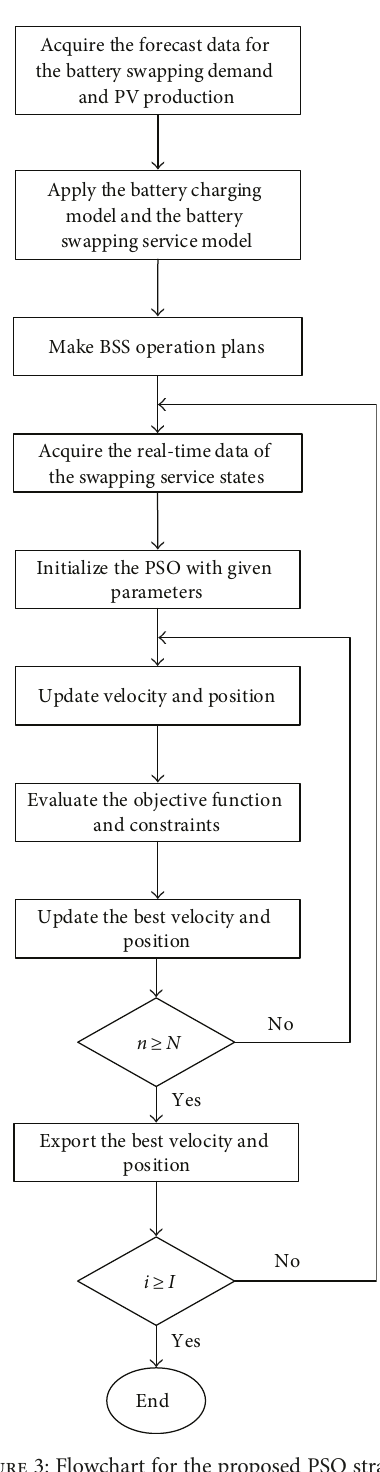
Figure 3: Flowchart for the proposed PSO